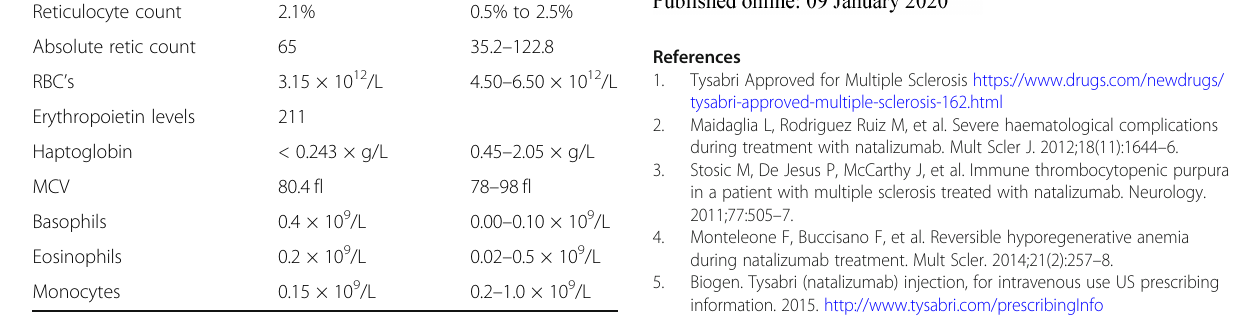
Table 1 Haematological parameters in November 2018 Blood parameters